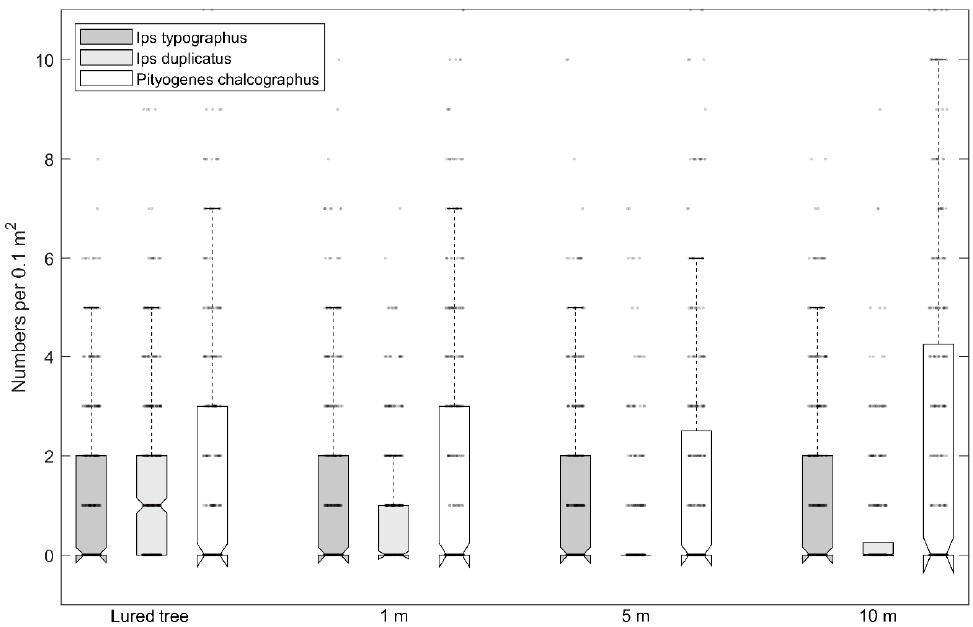
Figure 1. Number of Ips typographus, Ips duplicatus , and Pityogenes chalcographus nuptial chambers on felled trap trees with branches that had pheromone lures or that lacked pheromone lures; trees without lures were placed at 1, 5, or 10 m away from lure trees (notch-median; box plot—25% and 75% values; dotted line-minimum-maximum without extremes; circles-values). The notch depth represents the confidence interval.